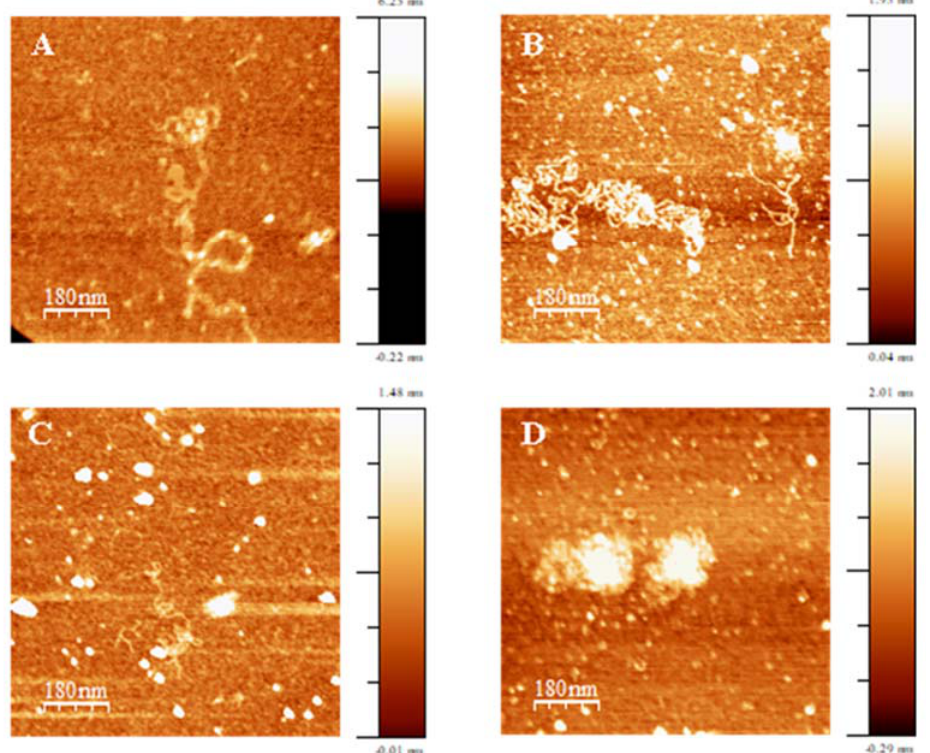
Figure 3. AFM topographic images of 12NBr/ctDNA buffered solutions, in 10 mM HEPES (pH = 7.4), adsorbed on APTES modified mica surface. [ctDNA] = 0.6 µM. ( A ) Pure ctDNA; ( B ) N/P =0.5; ( C ) N/P = 0.9; ( D ) N/P = 3.0.